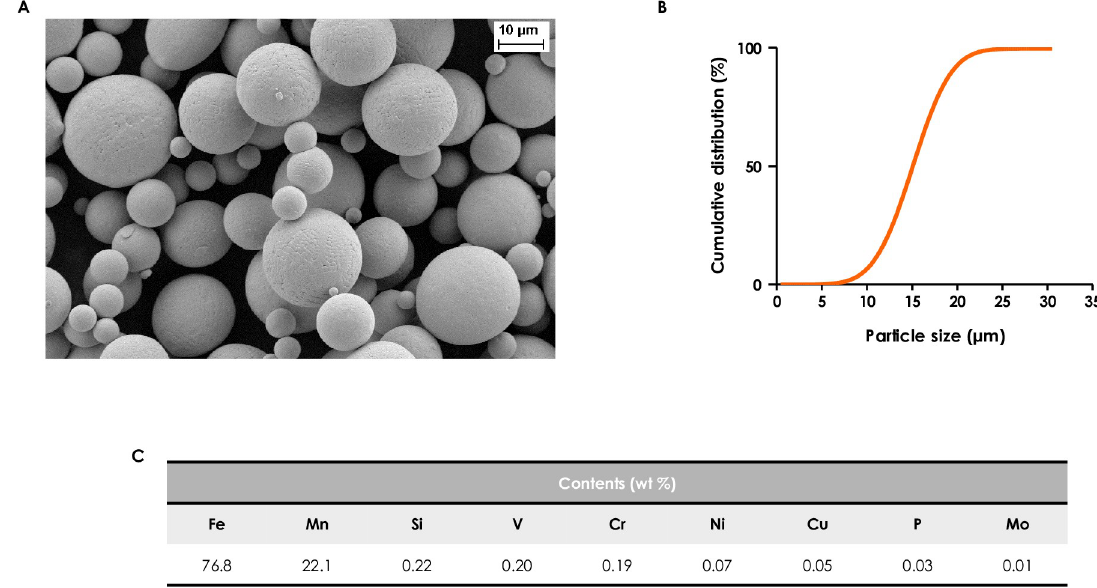
Fig 1. Characterization of TWIP steel powder. (A) SEM micrograph; (B) particle size distribution; (C) elemental composition. https://doi.org/10.1371/journal.pone.0231634.g001 24h. Cells were then washed twice with DPBS 1X and incubated in fresh medium with 10% WST-1 reagent for 2h. Absorbance was measured at 450 nm (690 nm was used as reference wavelength and subtracted) in a multiplate reader (Infinite F200, Tecan 1 ). For some experi- ments, the full visible spectrum was recorded. Results are reported as relative WST-1 activity, where 1.0 corresponds to the absorbance measured in control cultures. Optical microscopy images of cells were taken with ZEISS Axiocam MRc microscope camera.